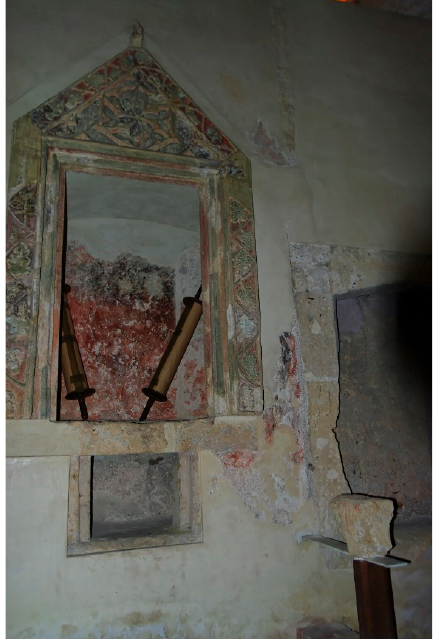
Figure 7. Old Synagogue, Sopron (Creative Commons, Emmanuel Dyan).